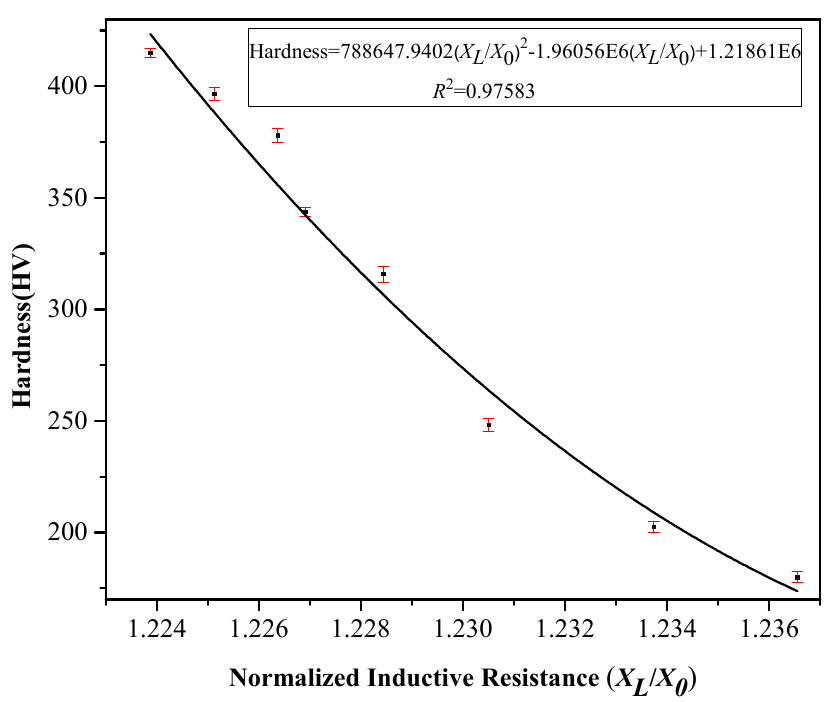
Figure 7. Relationship between the normalized inductive resistance and the hardness.